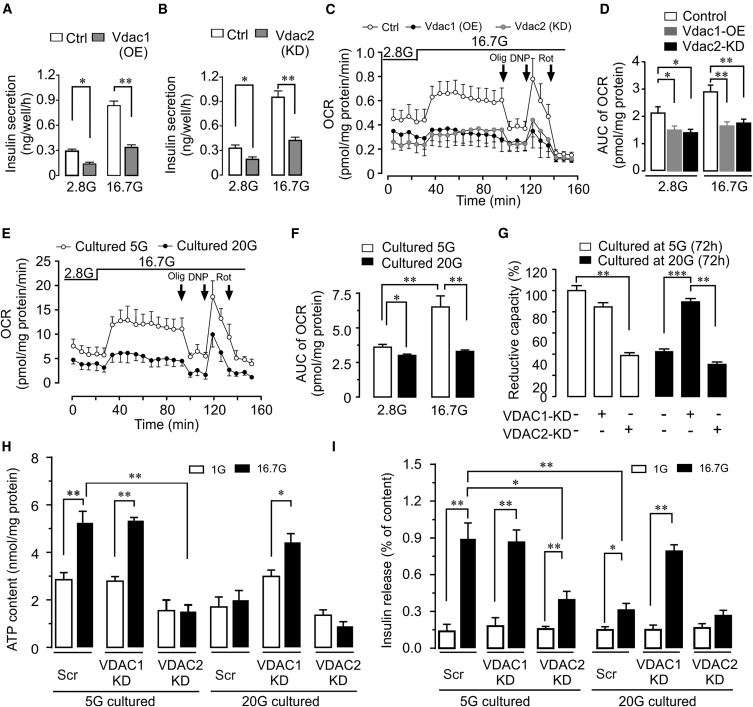
Impact of VDAC1 on β Cell Function(A and B) Glucose-stimulated insulin secretion (GSIS) in INS-1 cells after overexpression of Vdac1 (OE) (A) or knockdown (KD) of Vdac2 (B) (n = 5).(C) Oxygen consumption rate (OCR) in INS-1 cells after overexpression of Vdac1 or KD of Vdac2. Subsequent additions were as follows: oligomycin ([Olig], an inhibitor of ATP synthase) (0.4 μM), dinitrophenol ([DNP], an uncoupler) (0.4 μM), and rotenone ([Rot], an inhibitor of complex (I) (0.1 μM).(D) Area under the curve (AUC) for the experiments in (C) (n = 5).(E and F) OCR of INS-1 cells cultured at 5 or 20 mM glucose (72 hr) (n = 5).(G) VDAC1 silencing protects human islet cells from glucotoxicity-induced decrease in cellular reductive capacity (formazone production), while VDAC2 KD is harmful. Islets from five donors (used in separate experiments) were cultured at either 5 or 20 mM glucose for 72 hr.(H) Effect of VDAC1 or VDAC2 KD on ATP content of islets cultured at 5 or 20 mM glucose (72 hr) and incubated at 1 or 16.7 mM glucose for 1 hr (n = 3 donors).(I) Insulin secretion for the same islets as in (H).